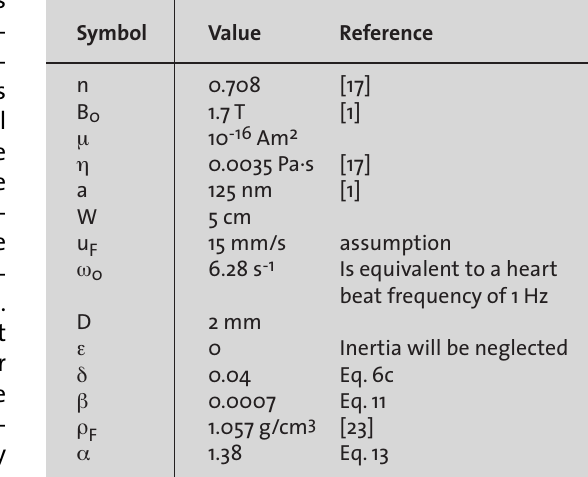
Table 1: Main parameters for the